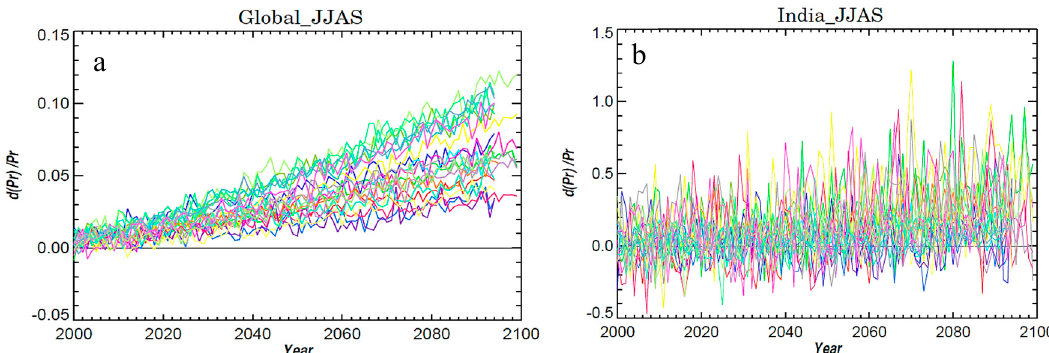
Figure 6. Precipitation (Pr) time series using various CMIP5 models for the whole globe ( a ) and for the Indian subcontinent ( b ). Time series are plotted for a period (1985–2005).